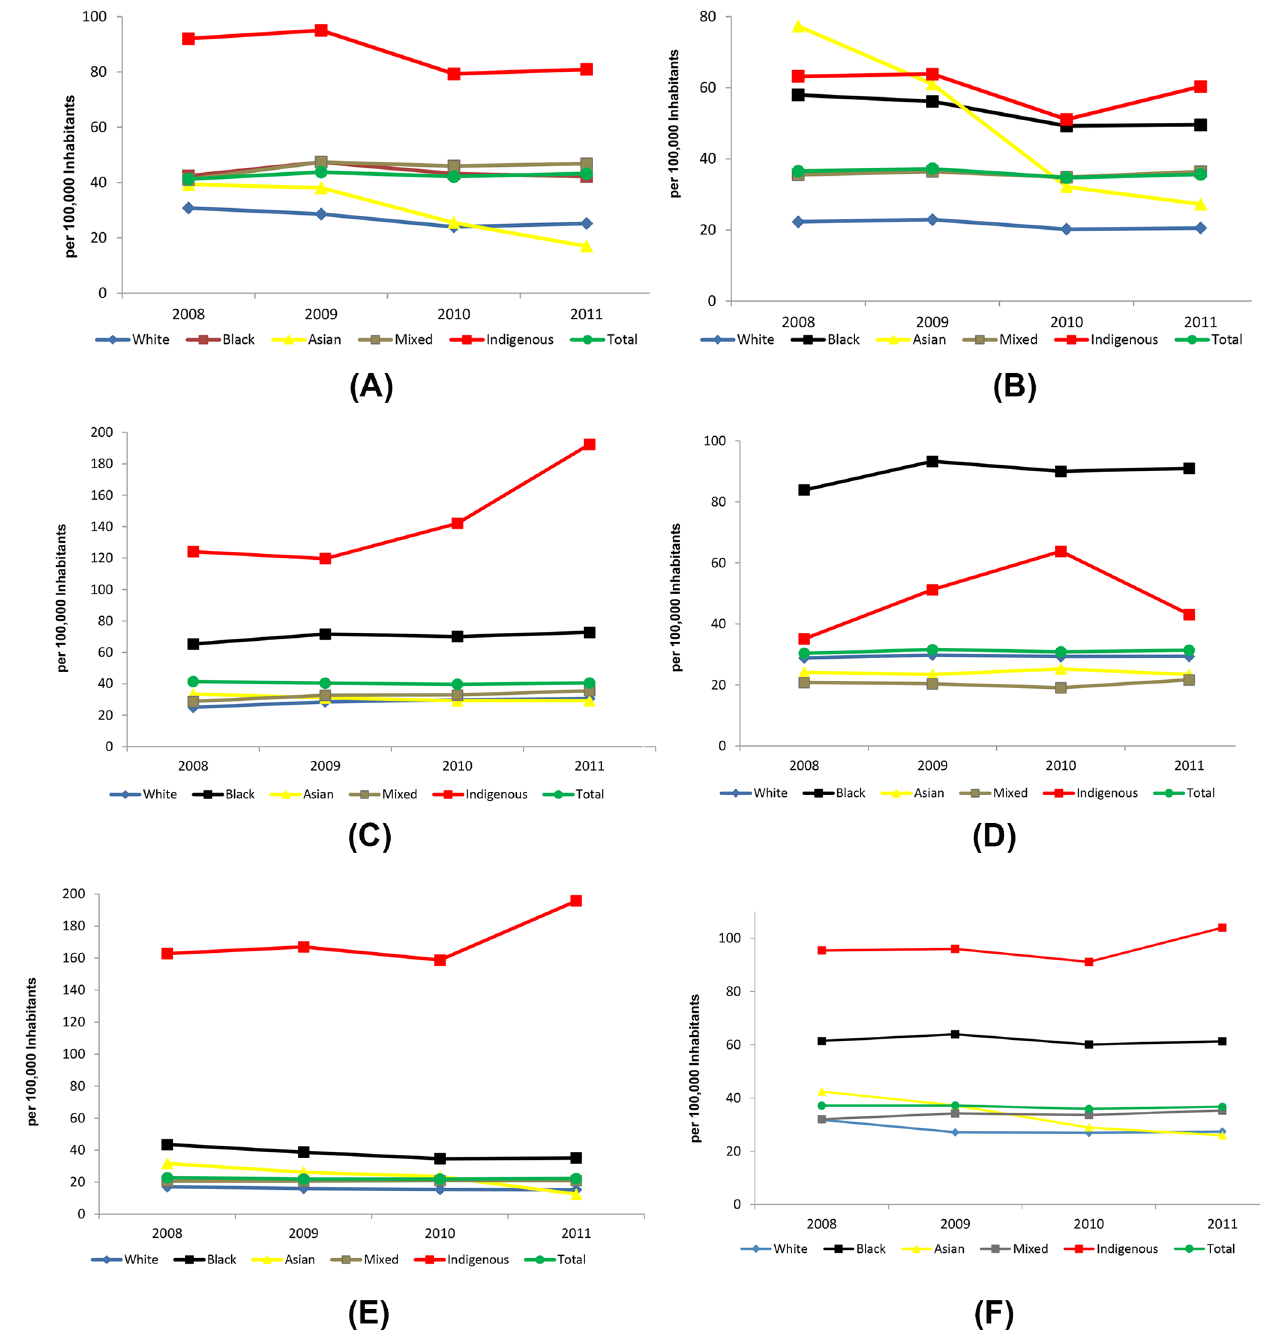
Fig 1. Incidence rate (per 100,000) of all clinical forms of tuberculosis, according to race and country macro-region, Brazil 2008 – 2011. Note: Each letter represents one macro-region from the total area of Brazil: (A) North; (B) Northeast; (C) Southeast; (D) South; (E) Central-West; and (F)